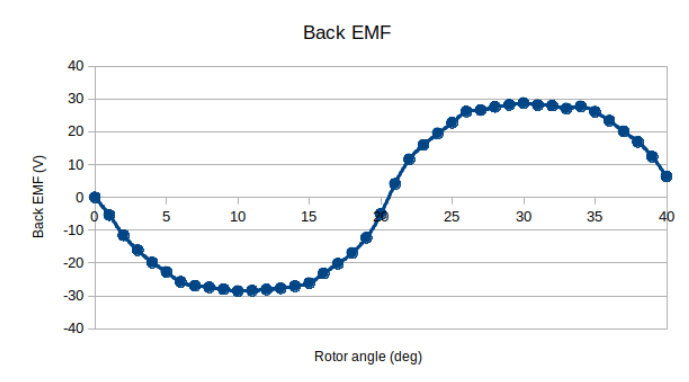
Figure 16. Back electromotive